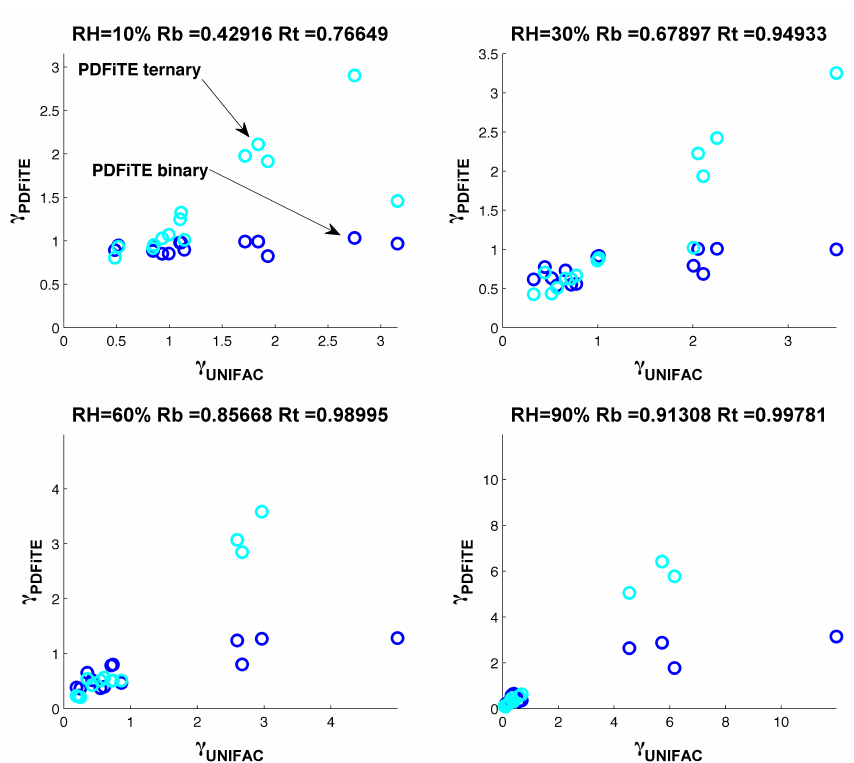
Fig. 4. Comparing binary/ternary PD-FiTE and UNIFAC for a random specific testcase. Each subplot represents a specific RH. Linear correlation coefficients are given in each subplot title. ’Rb’ and ’Rt’ are the correlation coefficients for the binary and ternary model, respectively. For this specific example, the compounds with the largest deviations from the binary model are 3, 4, 7, 8, 9 and 10. The compound numbers and SMILES strings are listed in Table 1 and average percentage deviations in Table 4.